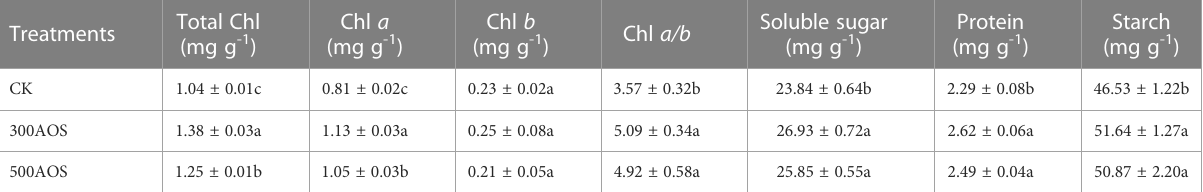
TABLE 1 Effect of AOS on assimilation products of citrus leaves.